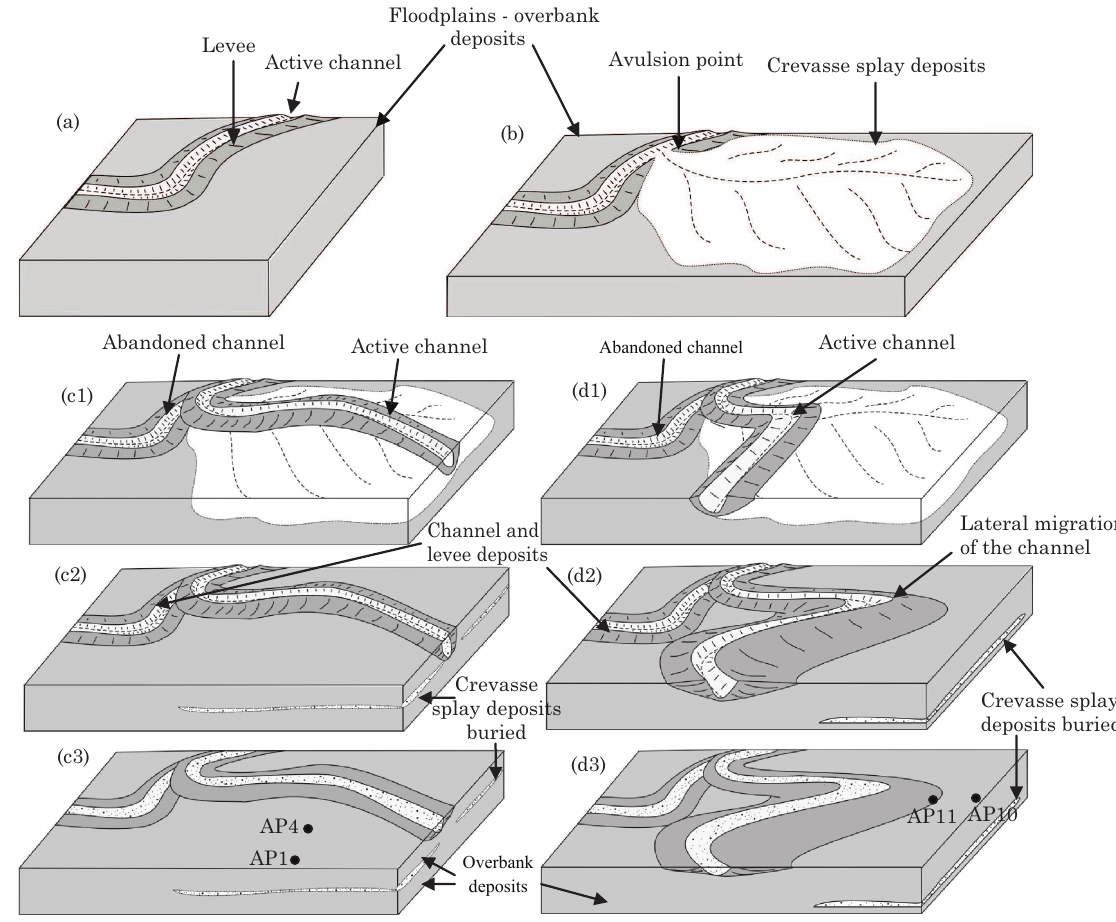
Figure 9. Evolution of the avulsion process and fluvial system that resulted in the formation of the soils (Figure 9c2,c3,d2,d3), which allowed this configuration with predominantly fine horizons that overlay the sandy sediments of avulsions.